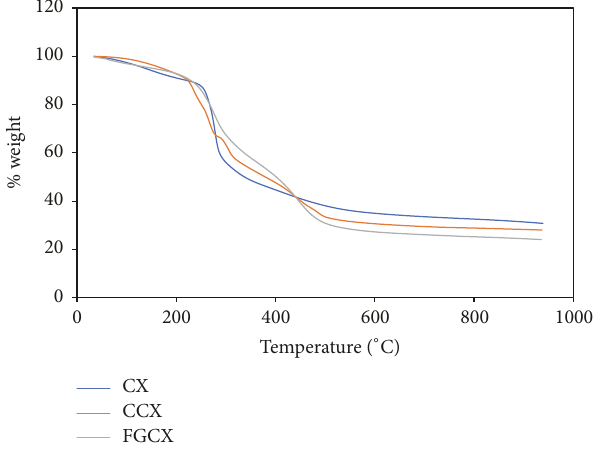
Figure 6: TGA of CX, CCX, and FGCX.